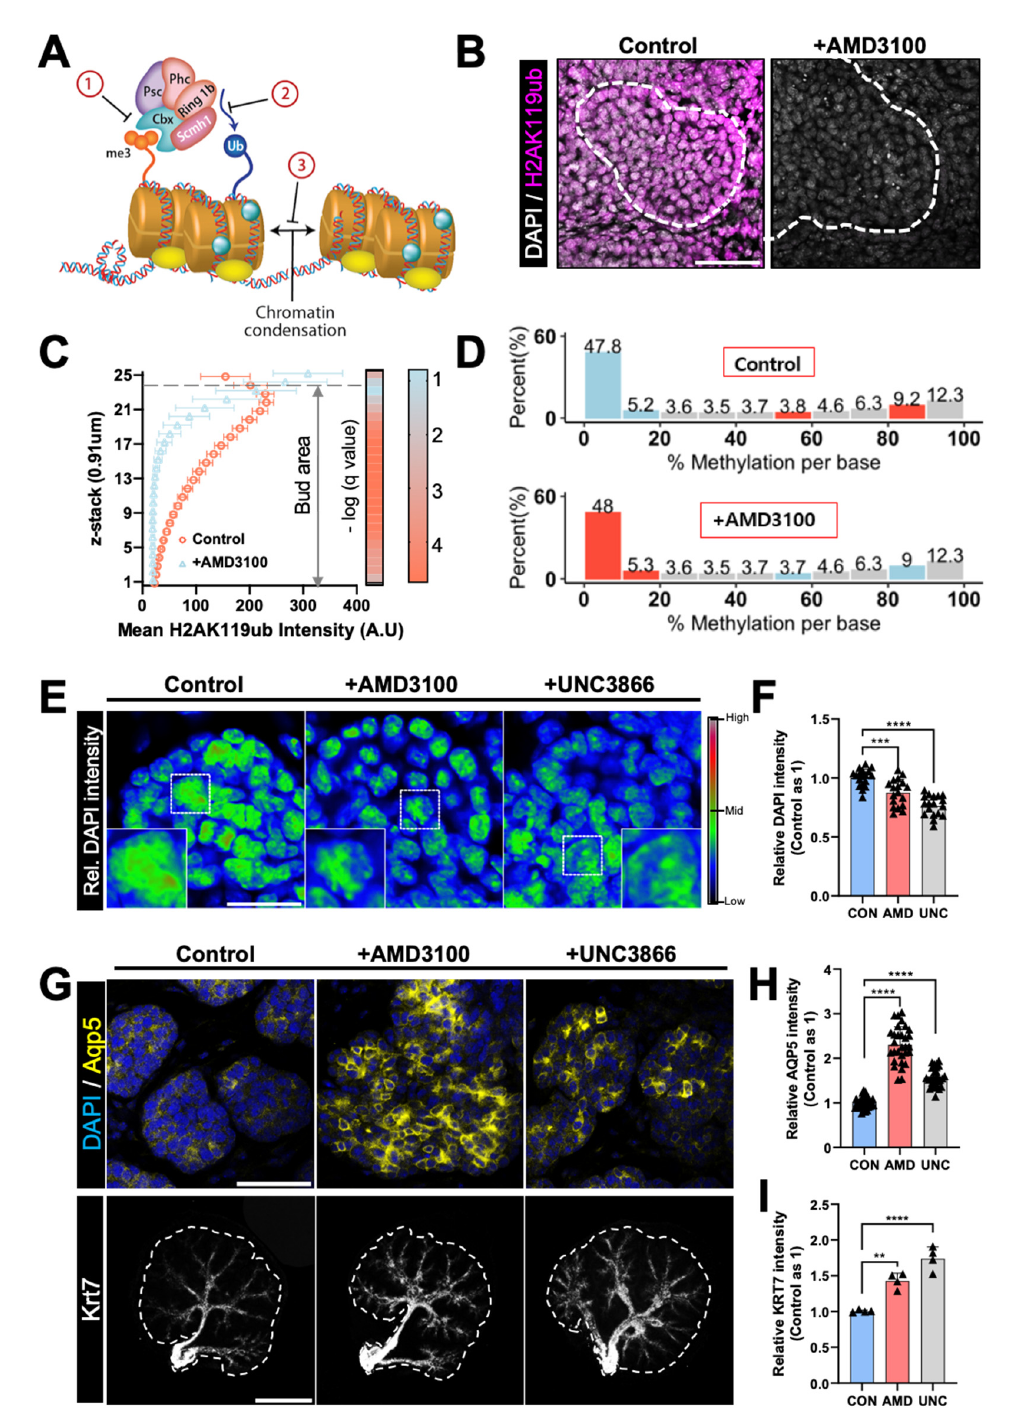
and 5I). In addition, the subduct lengths were also decreased in UNC3866-treated eSMGs (Figure S5B), recapitulating the AMD3100-induced duct length decrement observed in Figure 2C. Together, these results suggest that abnormal demethylation and transcription of developmental genes caused by down-regulation of PRC1 components are the key mech- anisms for AMD3100-induced precocious differentiation of ductal and acinar progenitor cells.